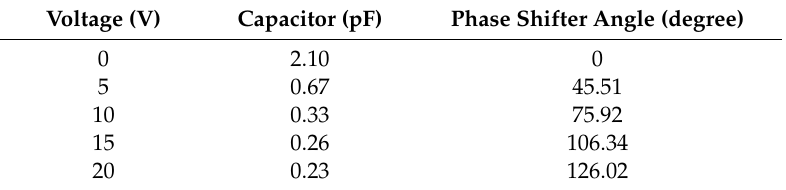
Figure 5. Schematic part of the SIW variable phase shifter and equivalent circuits of the varactor diodes.